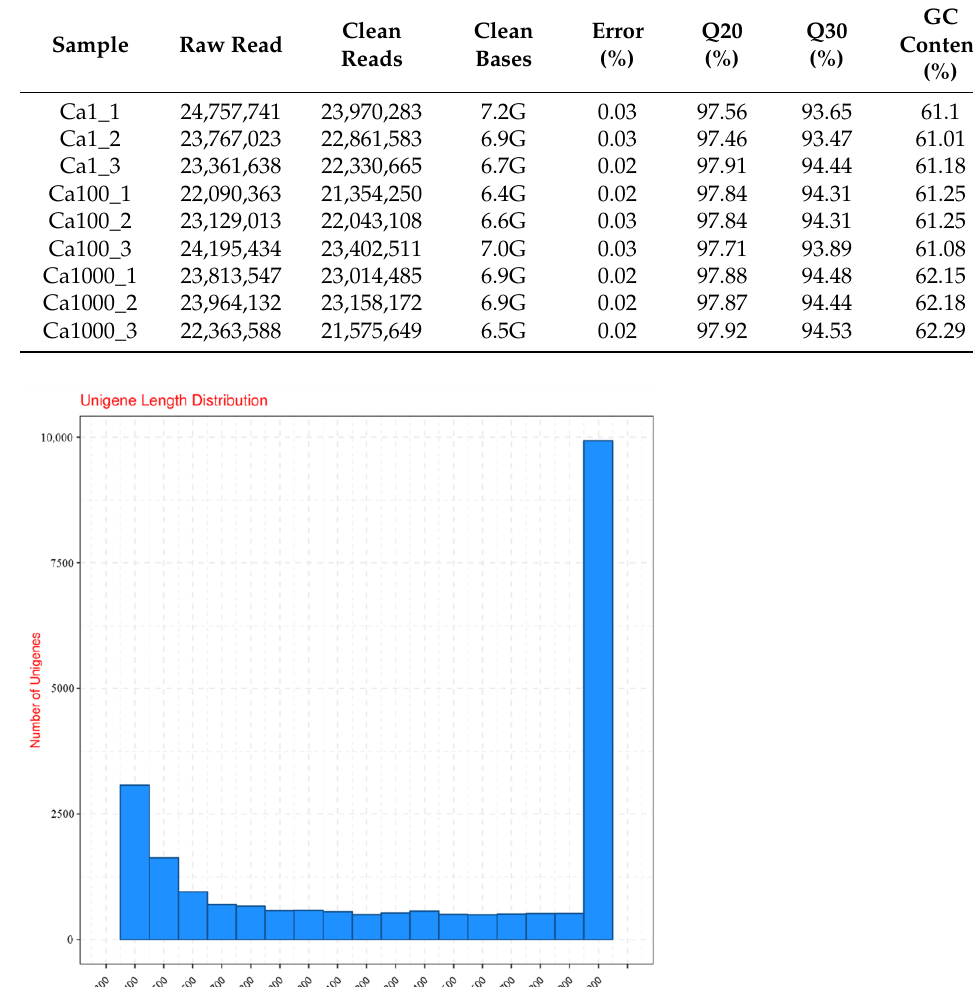
Table 1. Summary of Sequencing Data Quality of P. kessleri FACHB-3316.